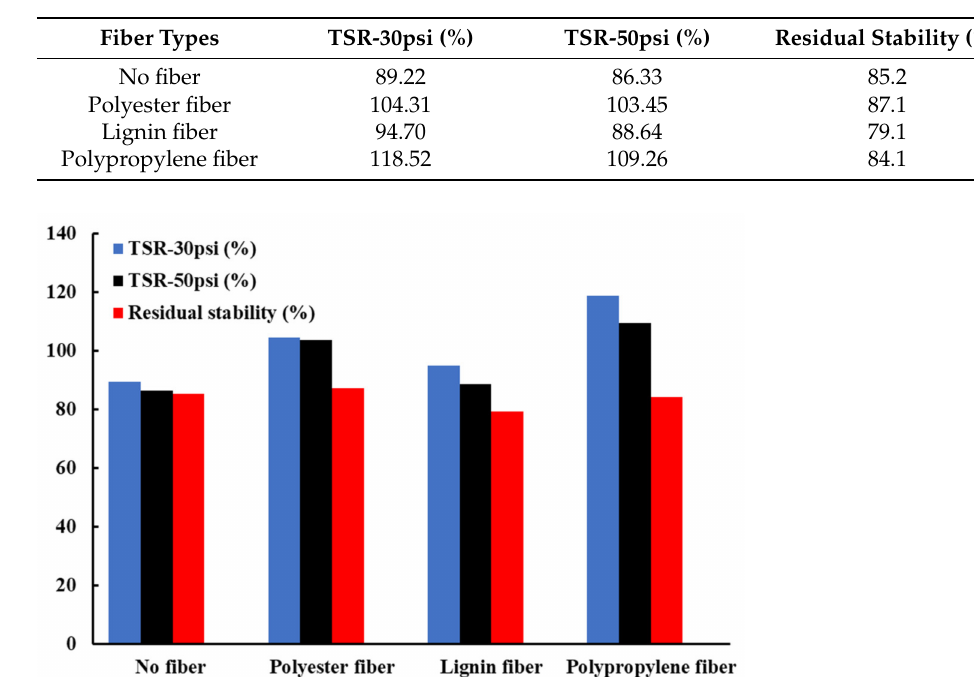
Table 8. General moisture resistance properties of the used fibers.